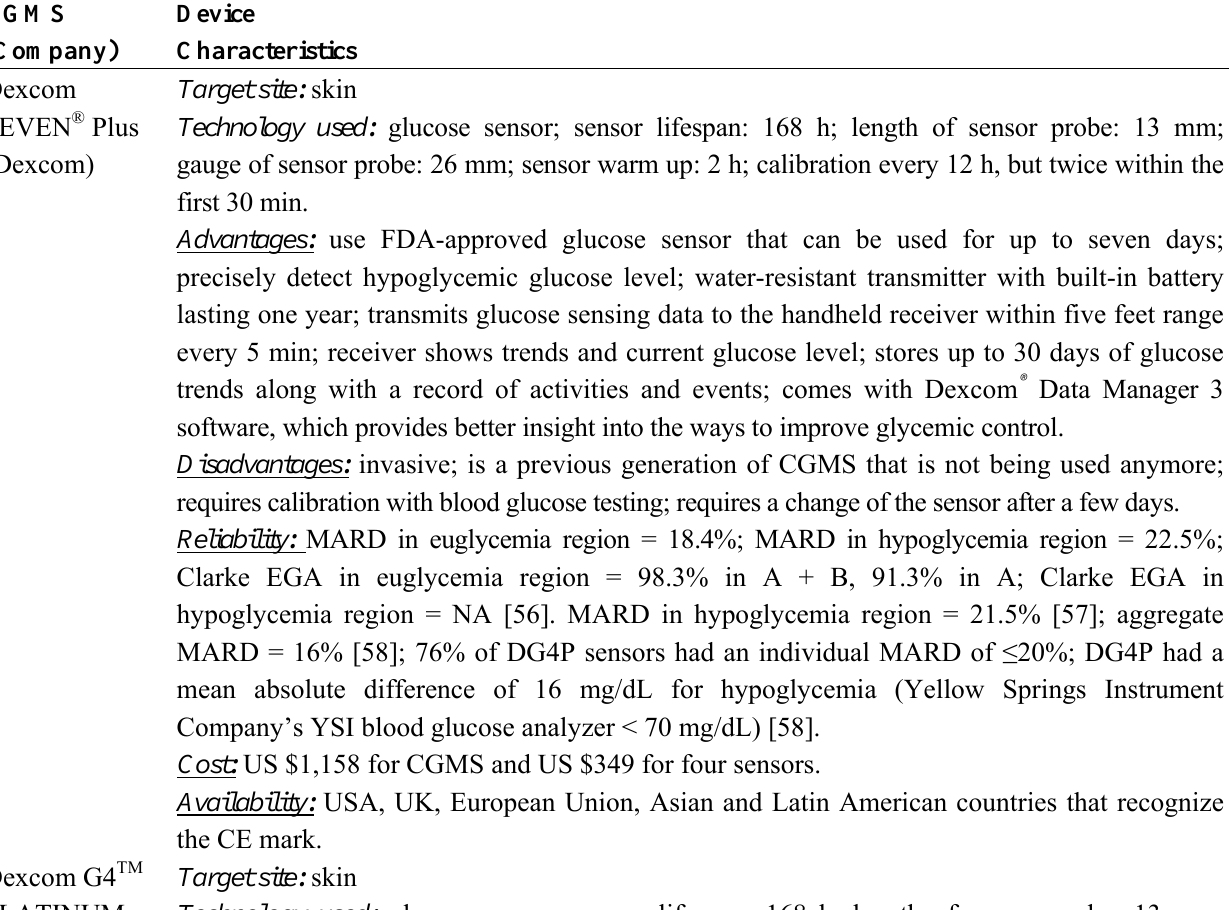
Table 1. Continuous glucose monitoring systems. MARD, mean absolute relative difference; EGA, error grid analysis; CE, Conformité Européenne; DG4P, Dexcom G4 TM PLATINUM; FN, FreeStyle Navigator ®